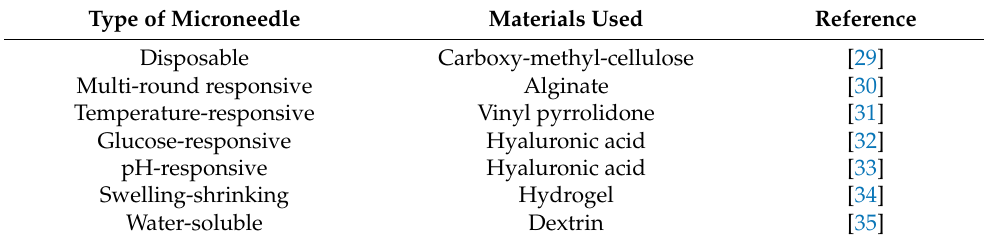
Table 2. Microneedle materials employed for current technological application [6].